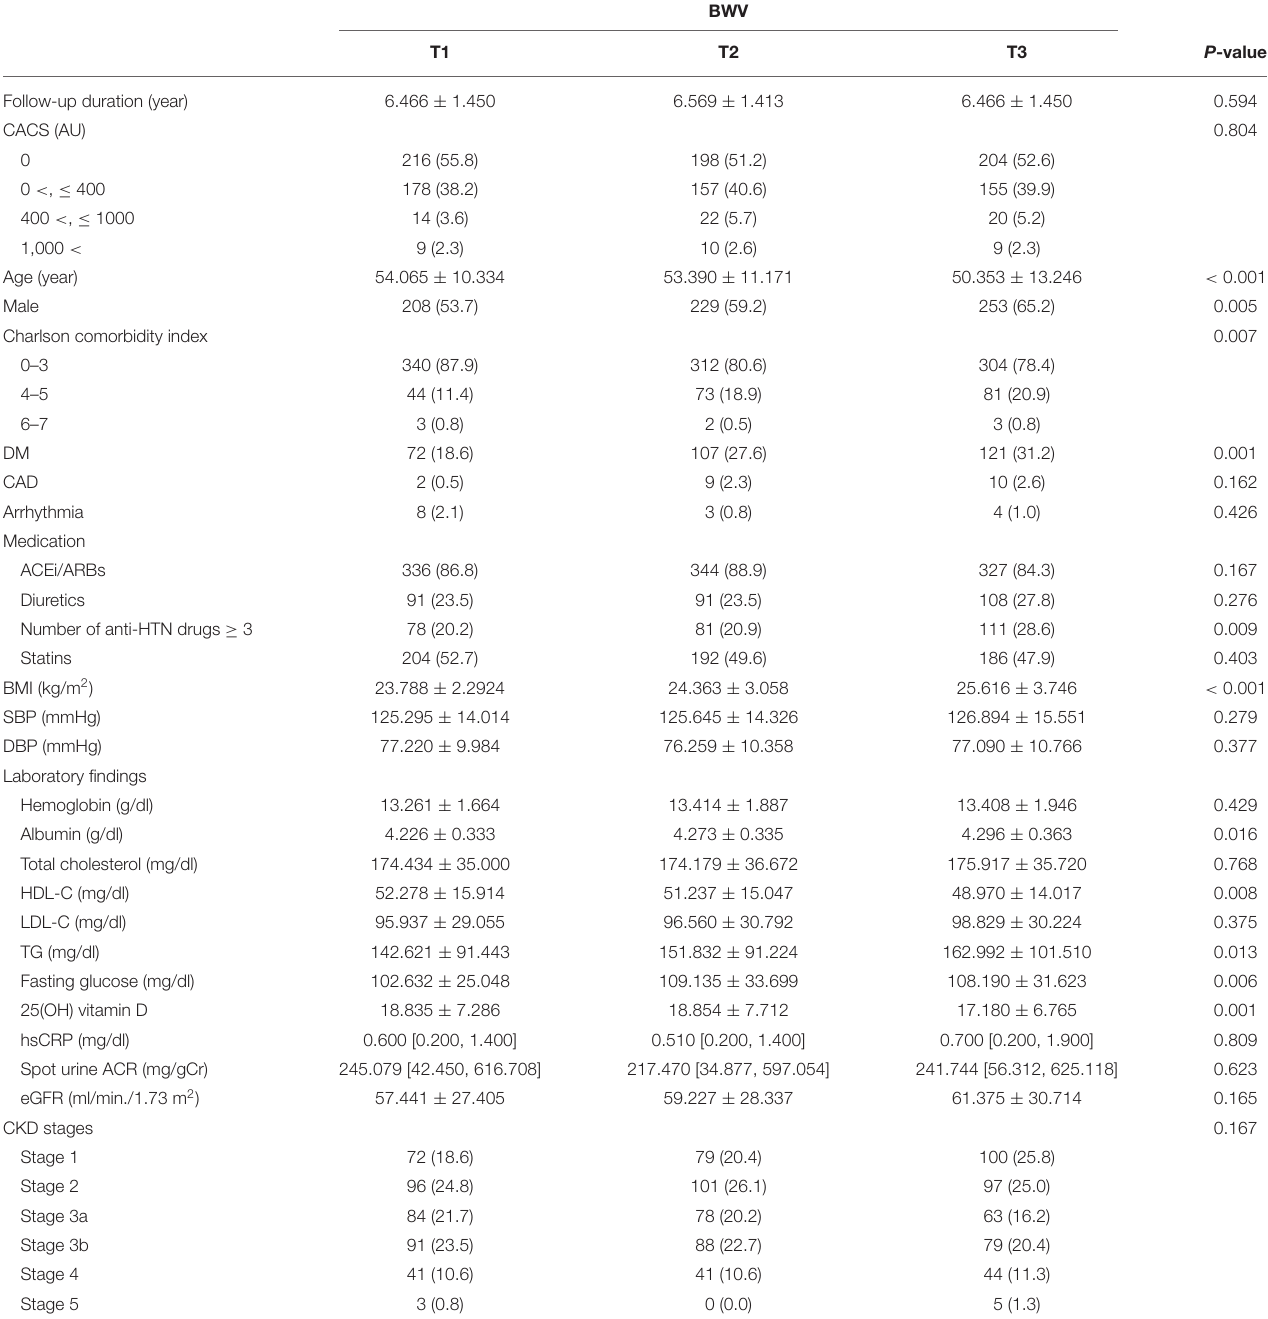
TABLE 1 | Baseline characteristics of study participants in the tertile by